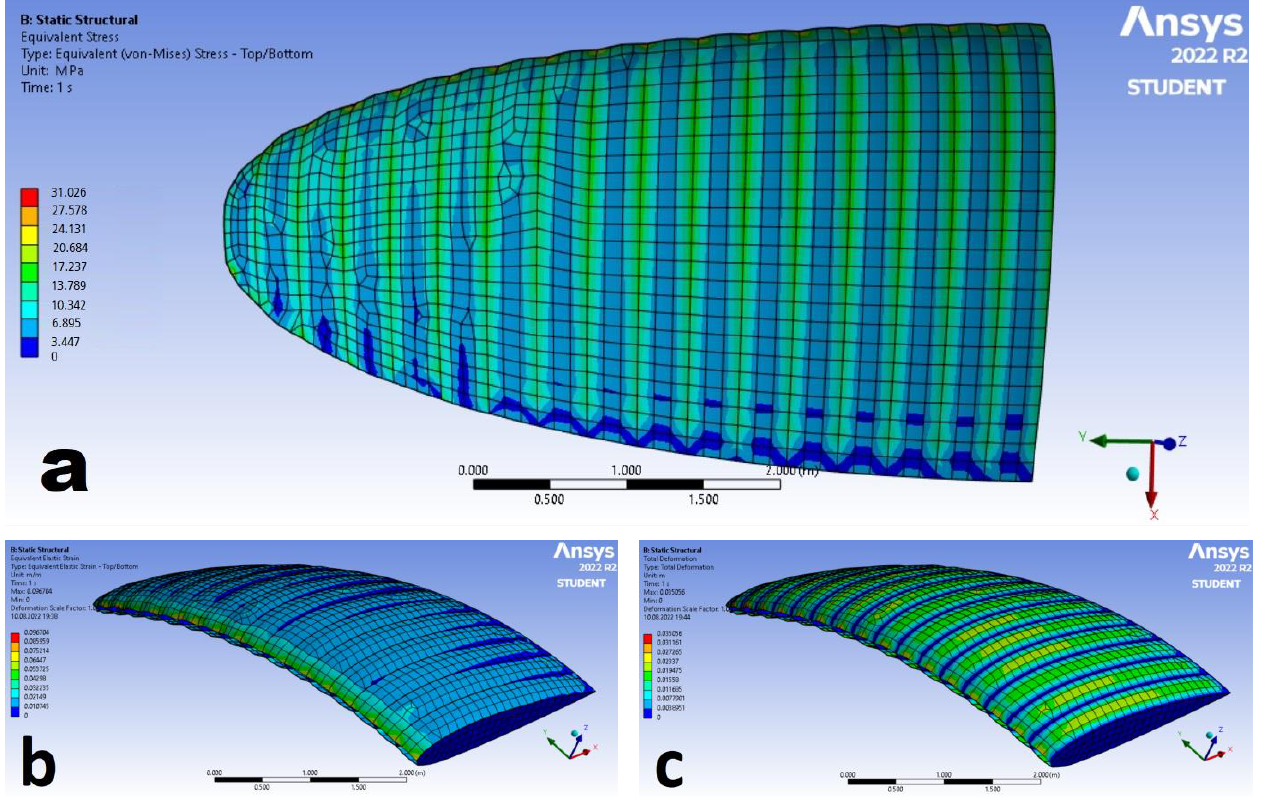
Figure 10. The exemplary distributions of ( a ) stress; ( b ) strain; and ( c ) deformation over the considered wing.